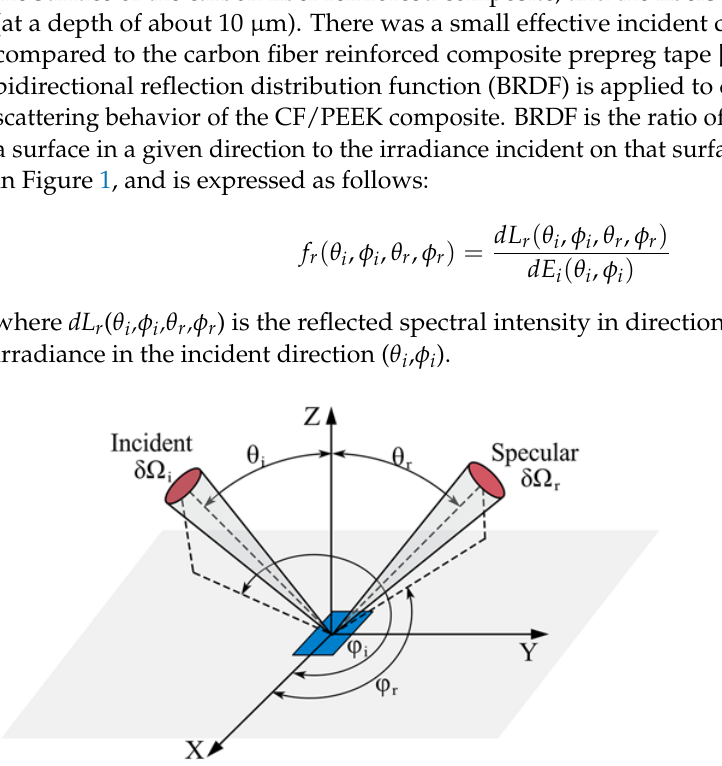
Figure 1. The definition of Bidirectional Reflection Distribution